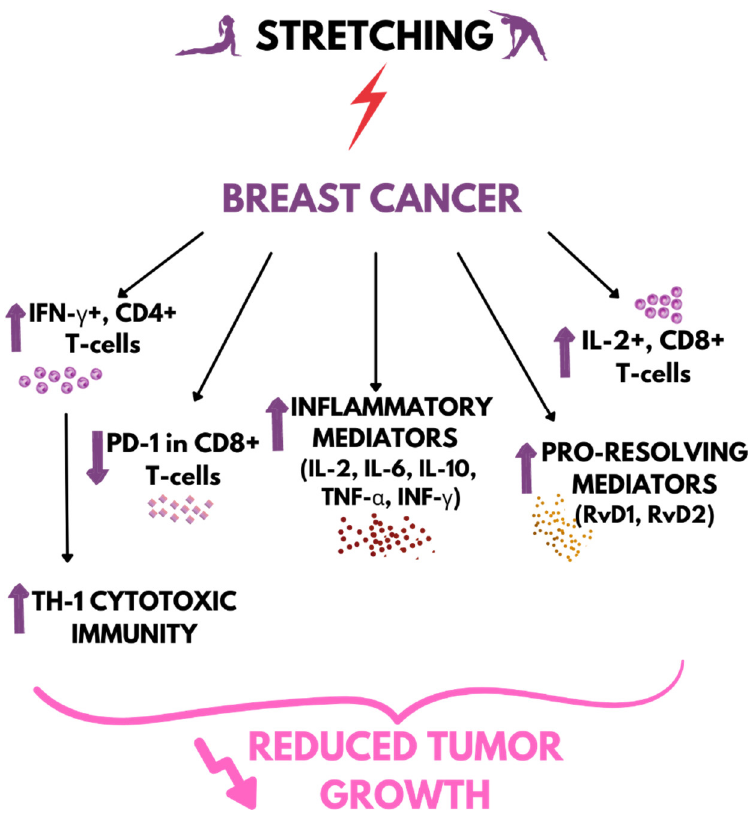
Figure 2. The effect of stretching on inflammatory factors in breast cancer mice.  increase/upregu- The effect of stretching on inflammatory factors in breast cancer mice. ↑ in- lation; ↓ decrease/downregulation. crease/upregulation; ↓